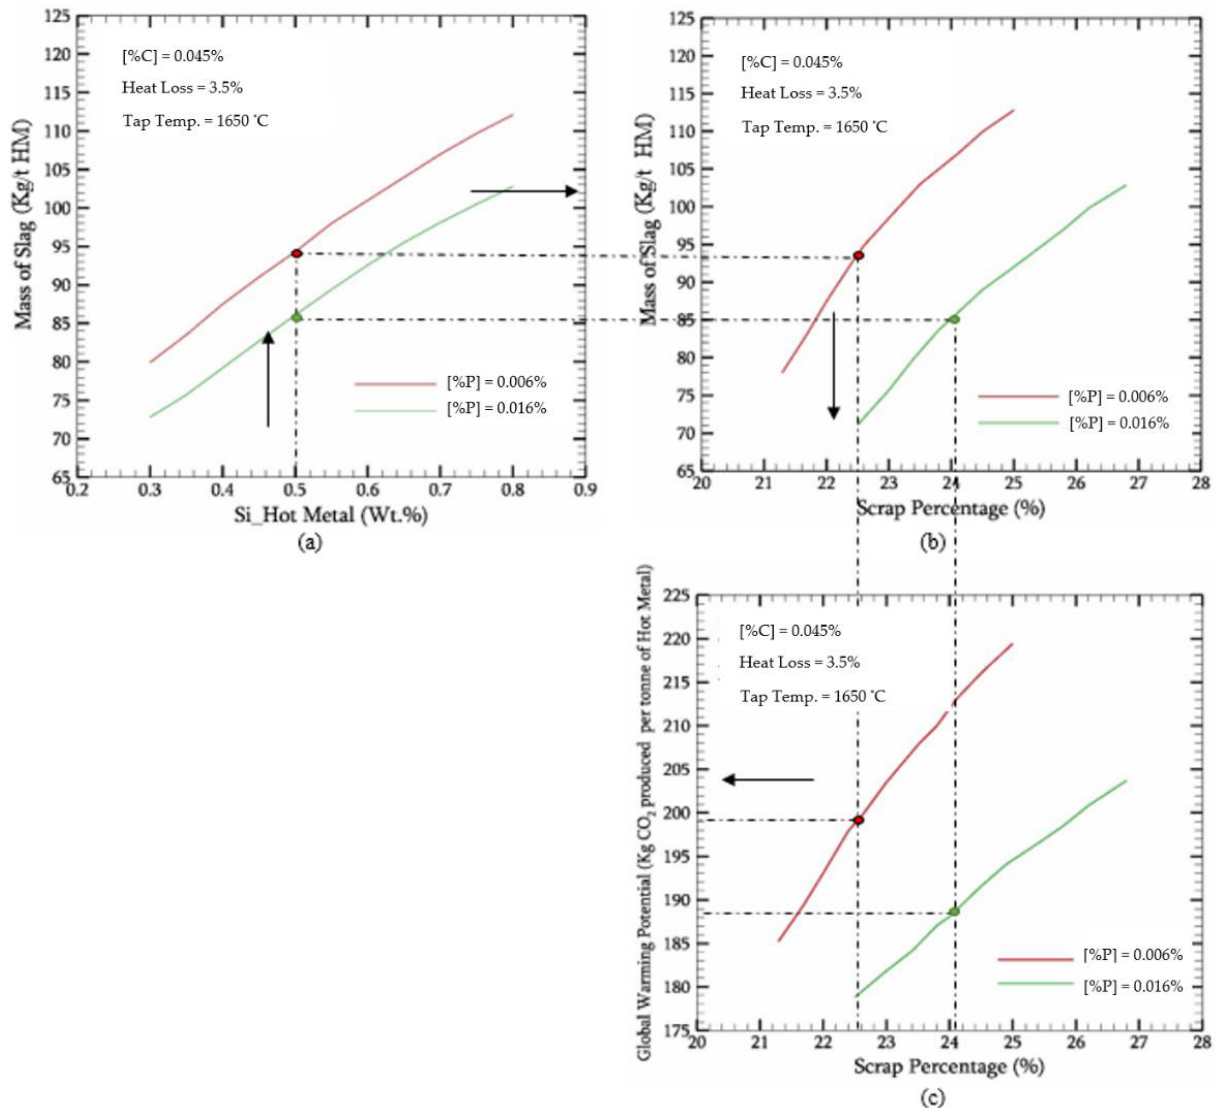
Figure 6. Nomogram from static balance model for top blow bottom stir technology with tap temperature of 1650 °C and assumed heat loss of 3.5%. ( a ) slag mass increase due to Si in Hot metal; ( b ) extra scrap due to additional heat; ( c ) additional amount of CO 2 .